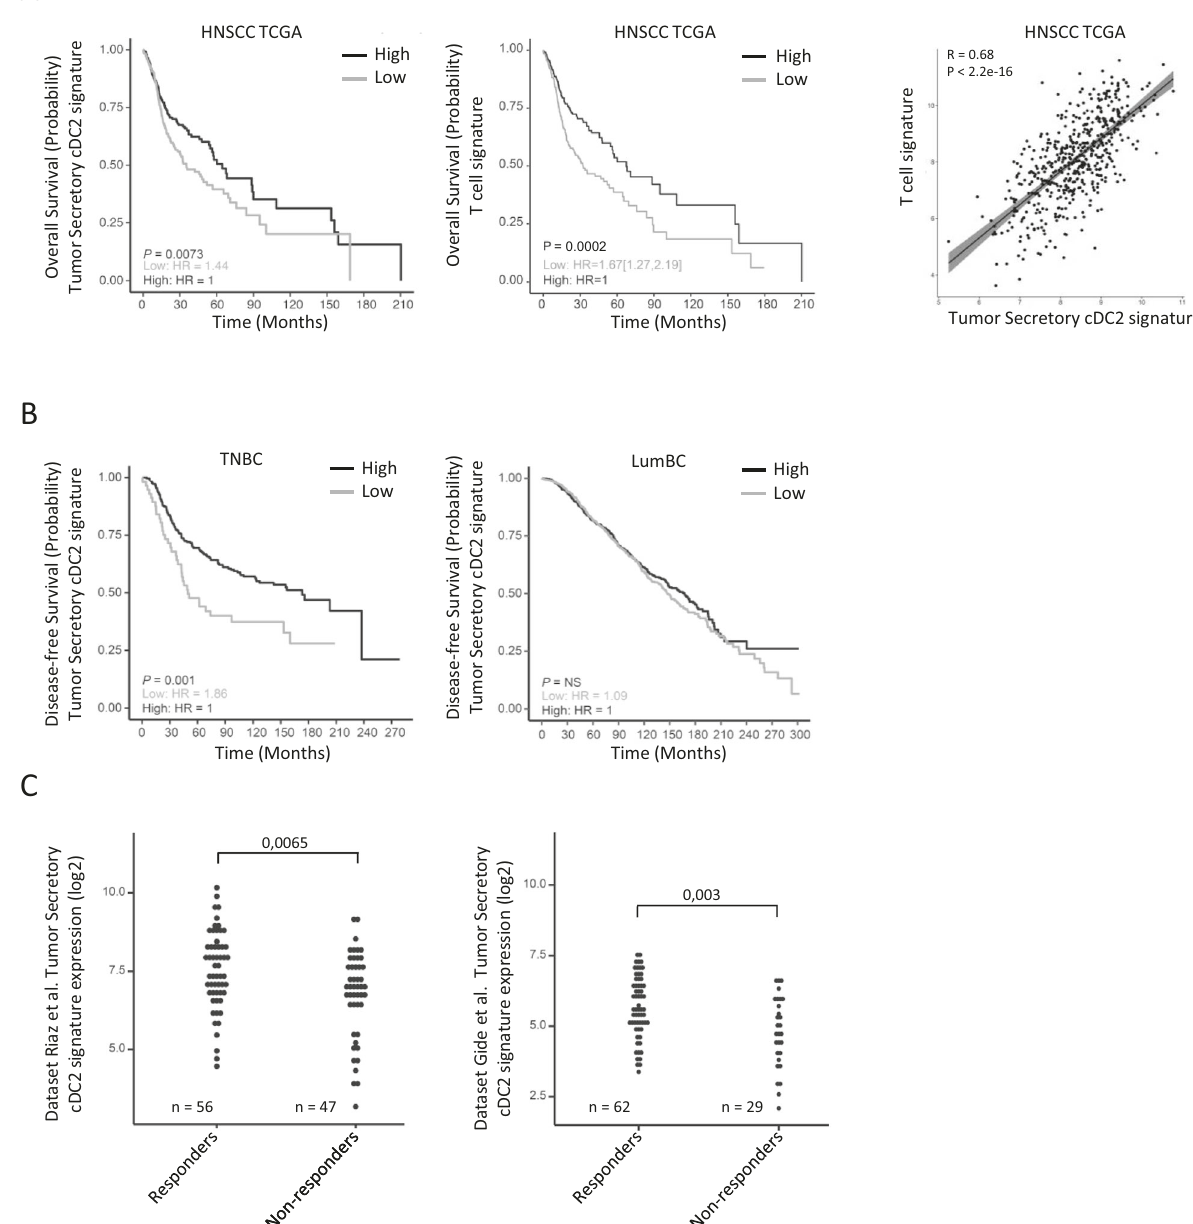
Fig. 5 Tumor secretory cDC2 are associated to good prognosis in in fl amed cancers and to response to immunotherapy. A Survival analysis among patients expressing high (black) and low (gray) levels of the 36-gene tumor secretory cDC2 signature (left) and T cell signature (center) (cutoff at median, log-rank test), among 500 non-metastatic HNSCC patients from The Cancer Genome Atlas (TCGA). Right: Pearson correlation between the 2 signatures in the same dataset. Line represents linear regression; grey zone represents 95% con fi dence interval. p -value is for two-sided statistical analysis. B Survival analysis as in A left for 318 triple negative breast cancer (TNBC) patients (left) and 1407 luminal breast cancer (LumBC) patients (right) from METABRIC dataset 24 . A, B : HR hazard ratio, NS not signi fi cant. C Tumor secretory cDC2 signature expression among responders and non-responders melanoma patients treated by immune checkpoint blockade from previous studies 27 (left) and 28 (right), two-sided Mann – Whitney tests. (Fig. 8A) that were annotated according to their DEG (Supple- inducers such as TSLP in allergy 39 , we merged single-cell tran- mentary Fig. 15 – 16; Supplementary Data 19 – 20), maturation scriptomic datasets from different tissues and contexts (Supple- markers expression (Fig. 8B), and tissue-speci fi city (Fig. 8C; Supplementary Fig. 14A, Supplementary Data 16); Luminal breast Supplementary Data 21). Cluster #4 presented with the most cancer (Supplementary Fig. 14B, Supplementary Data 17); Lung abundant expression of maturation markers including LAMP3, cancer 41 ); atopic dermatitis (AD) 42 (Supplementary Fig. 14C; CD80, CD40 (Fig. 8B), the migration marker CCR7 , and over- Supplementary Data 18); lupus nephritis 43 ; blood from cancer expressed the tumor Secretory cDC2 signature (Fig. 8D left), thus patients 40,41 ; and blood 40 , skin 42 , and tonsil 40 from healthy #4 was labeled mmDC. These cells were mostly abundant in patients, with a total of 111 samples. We identi fi ed 13 clusters cancer tissues, but also present in healthy and in fl amed skin, NATURE COMMUNICATIONS| (2022) 13:1983